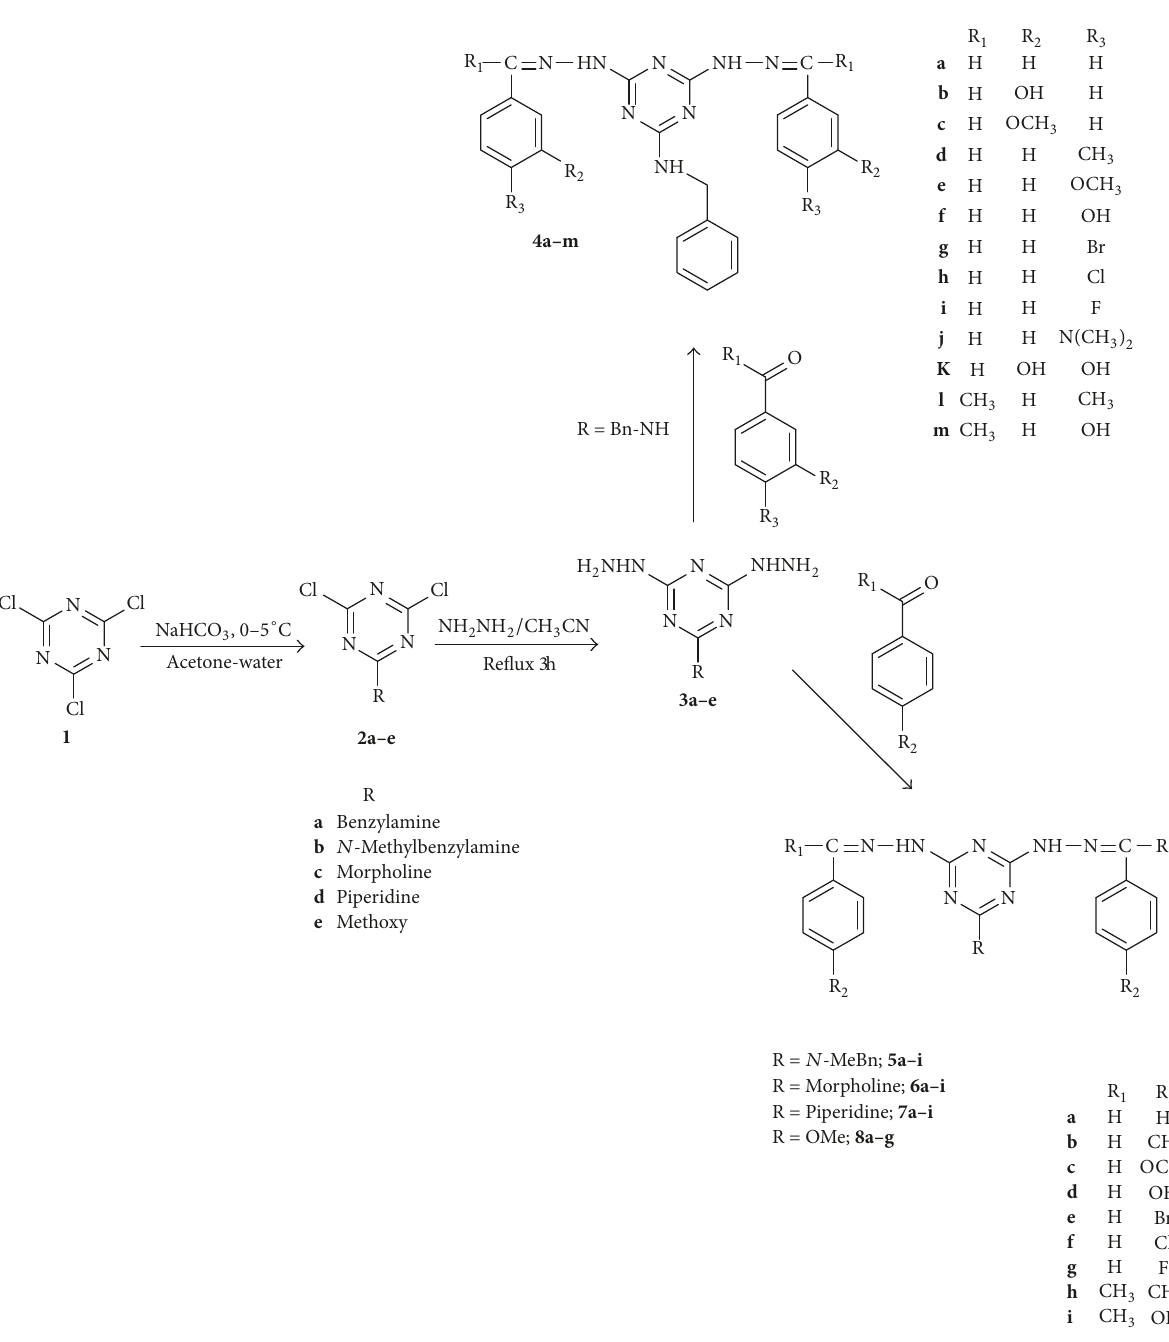
Scheme 1: Synthesis of 6-substituted-s-triazine-Schiff base